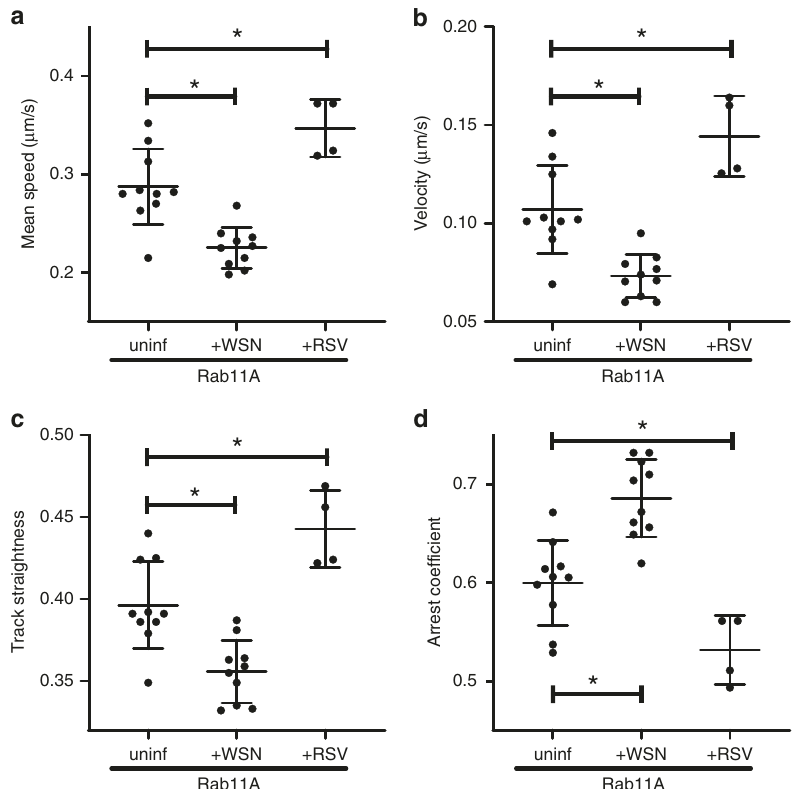
Fig. 5 Effect of viral infection on Rab11A motion: comparing RSV infection with IAV (WSN) infection. A549 cells stably expressing GFP-tagged Rab11A were infected with lab-adapted H1N1 strain (A/WSN/33) at MOI = 3 to allow a majority of cells to be infected. Imaging was performed 8 hpi at 37 °C on a temperature-controlled stage. Similarly, A549 cells stably expressing GFP-tagged Rab11A were infected with recombinant RFP-expressing RSV 53 at 0.1 plaque-forming units (pfu)/cell and imaging performed at 16 hpi. Infection with speci fi c strains is noted on the x -axis along with uninfected control (uninf.). Each datapoint represents an individual cell (uninfected: n = 10 cells, WSN: n = 10 cells, and RSV: n = 4 cells) using CF 50 for the corresponding motion parameters: a track mean speed, b track mean velocity, c track straightness, and d, track arrest coef fi cient. Image processing and analysis were performed as described in Methods. Mean± SD are shown per group (* implies p < 0.05, comparisons performed using one-way ANOVA with Tukey ’ s multiple tests). Source data are provided as a Source Data fi